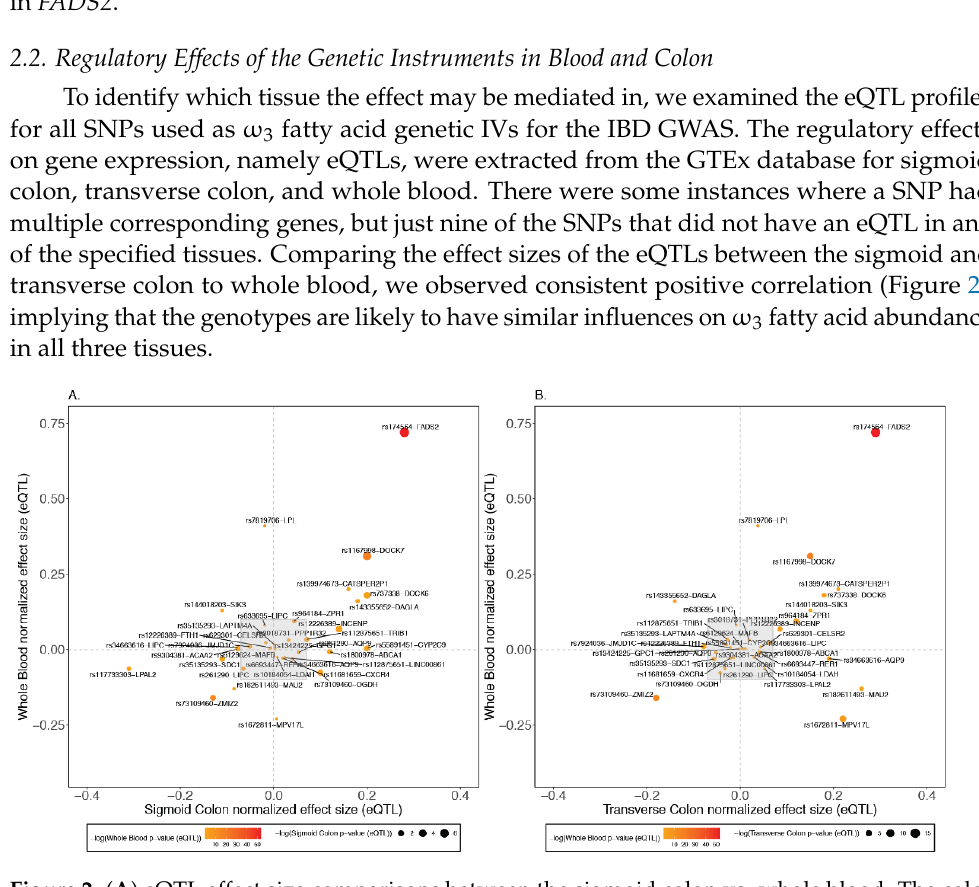
Figure 2. ( A ) eQTL effect size comparisons between the sigmoid colon vs. whole blood. The color of the points represent the − log10(whole blood p -value (eQTL)) and size of the points represent − log10(sigmoid colon p -value (eQTL)). ( B ) eQTL effect size comparisons between the transverse colon vs. whole blood. The color of the points represent the − log10(whole blood p -value (eQTL)) and size of the points represent − log10(transverse colon p -value (eQTL)). The grey boxes indicate SNPs that generally have eQTL effects with p > 0.05 in both